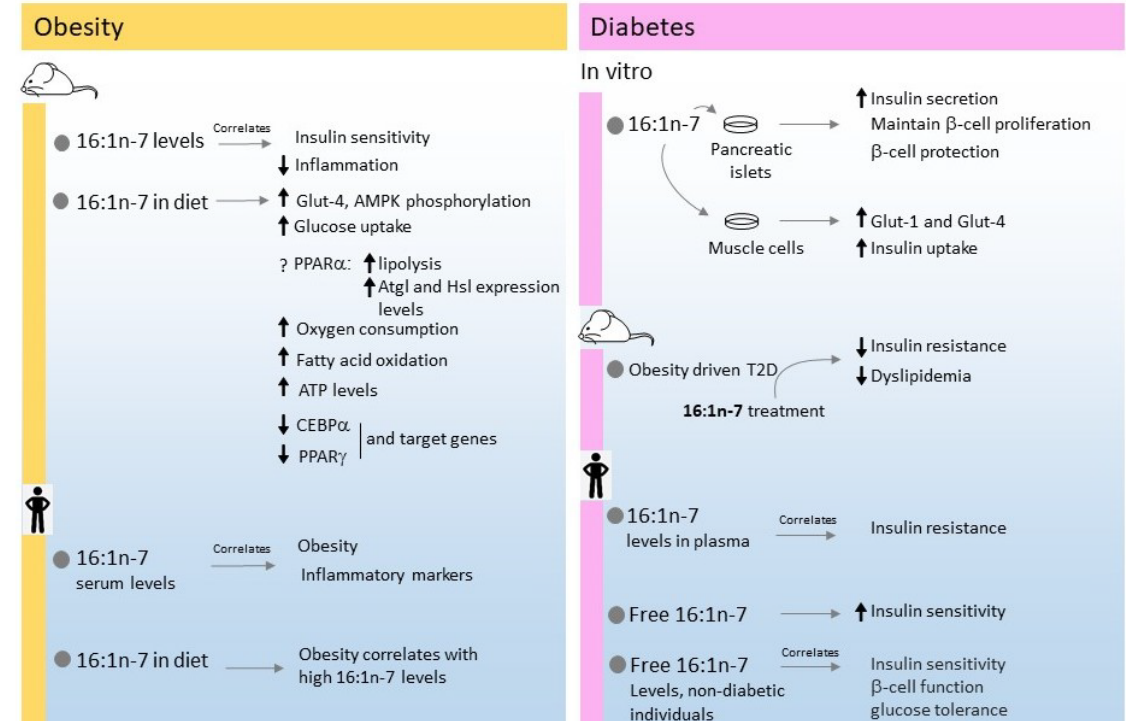
Figure 2. Summary of the effects of 16:1n-7 on metabolic and inflammatory conditions in obesity and diabetes.